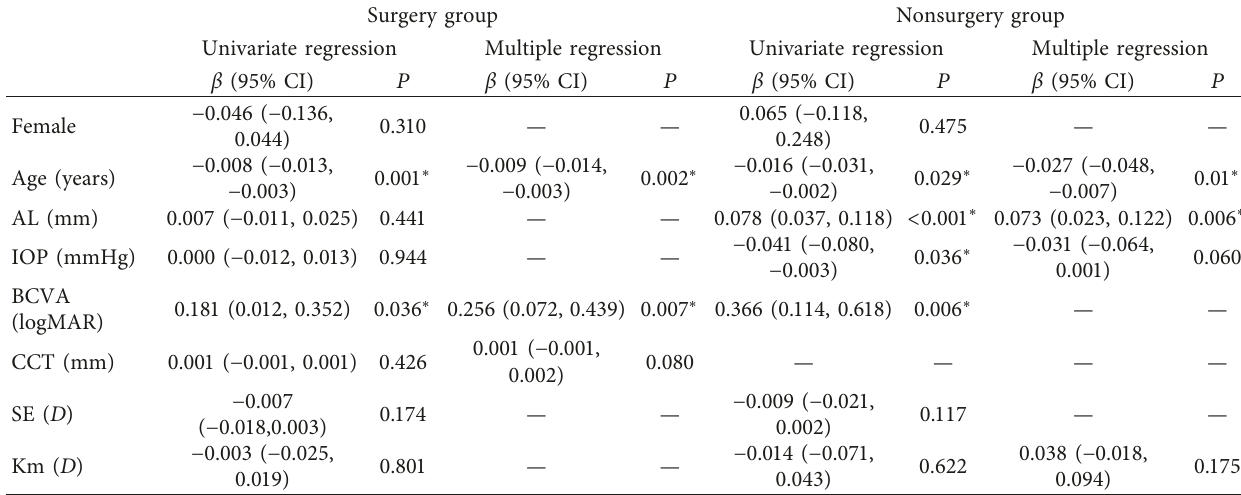
Table 3: Potential associated factors for axial length growth in CEL